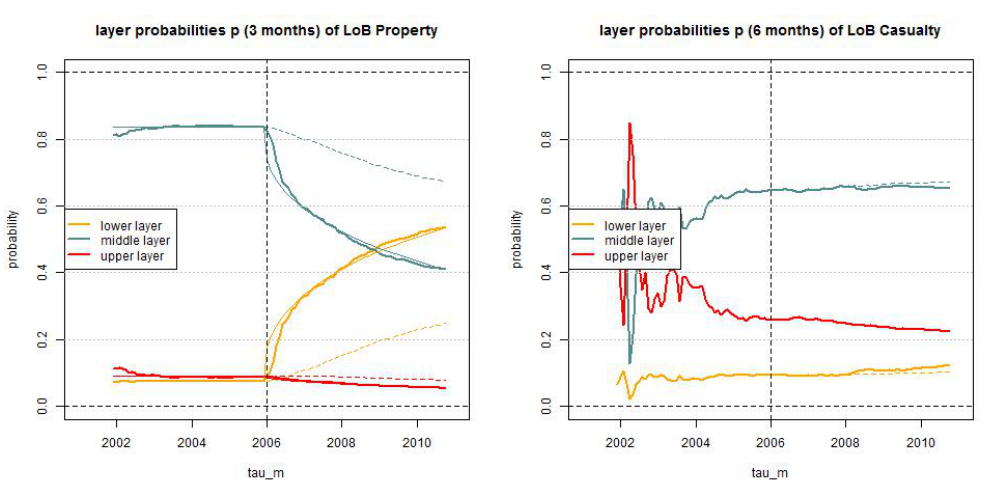
( n ) Figure 11. Estimated layer probabilities p , n = 1,2,3, in the truncated/shifted log-normal U | τ m , Θ model (lhs) LoB Property with u ( 2 ) = 3 and (rhs) LoB Casualty with u ( 2 ) = 6 months for τ m ∈ { 31/12/2010, . . . ,31/10/2010 } ; the solid lines give the dynamic versions α > 0 with γ = 1/4 and the dotted lines the static versions α =